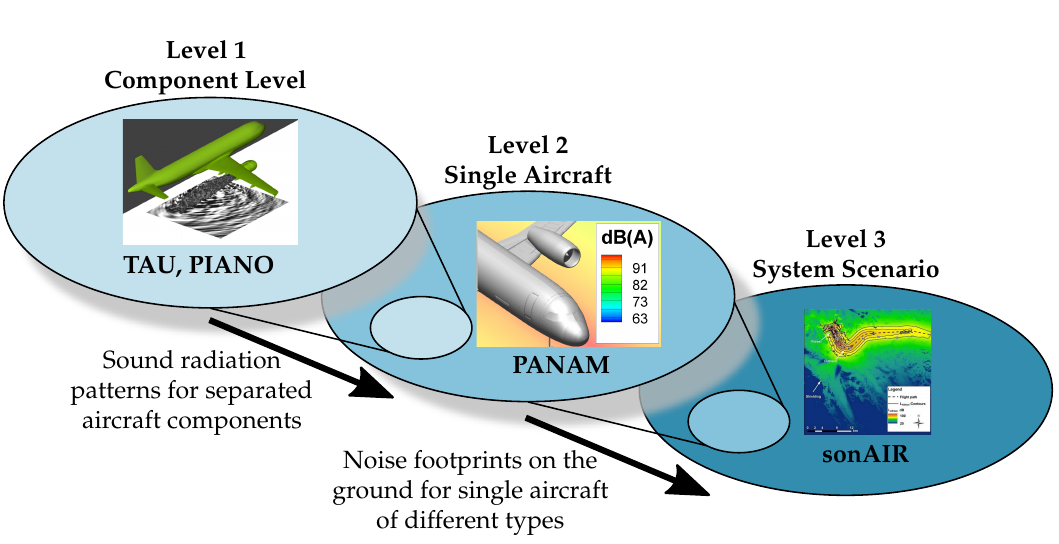
Figure 1. The noise prediction chain made up of Computational Fluid Dynamics (CFD) code TAU, Computational Aeroacoustics (CAA) code PIANO, Parametric Aircraft Noise Analysis Module (PANAM) tool for noise emission and sonAIR for ground noise exposure